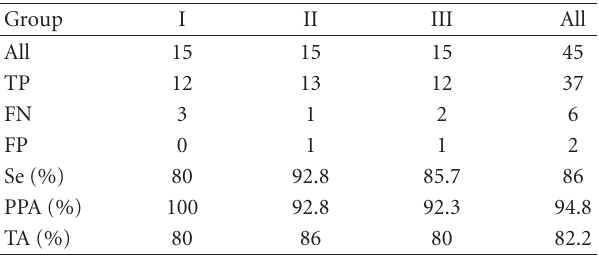
Table 7: Results of testing the algorithm on Physionet database.